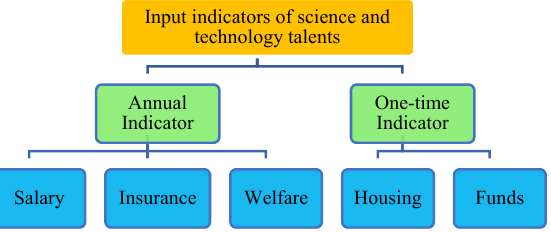
Figure 1. Input indicators of science and technology talents.